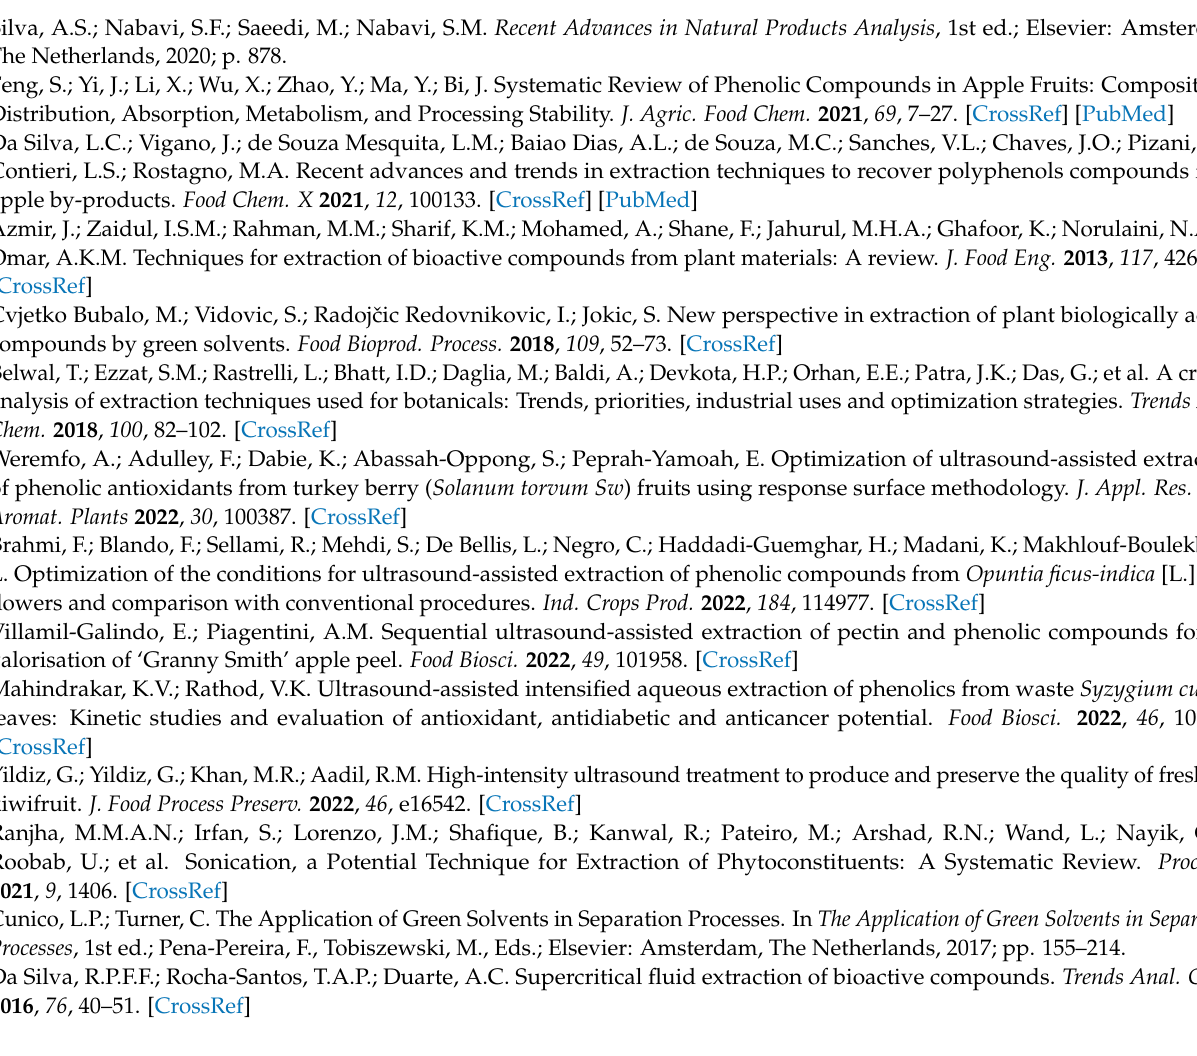
Figure S9. Bland–Altman test comparing the extracted amounts of phenolics using GXLE and UE.; Figure S10. AGREE protocol for GXLE.; Figure S11. AGREE protocol for